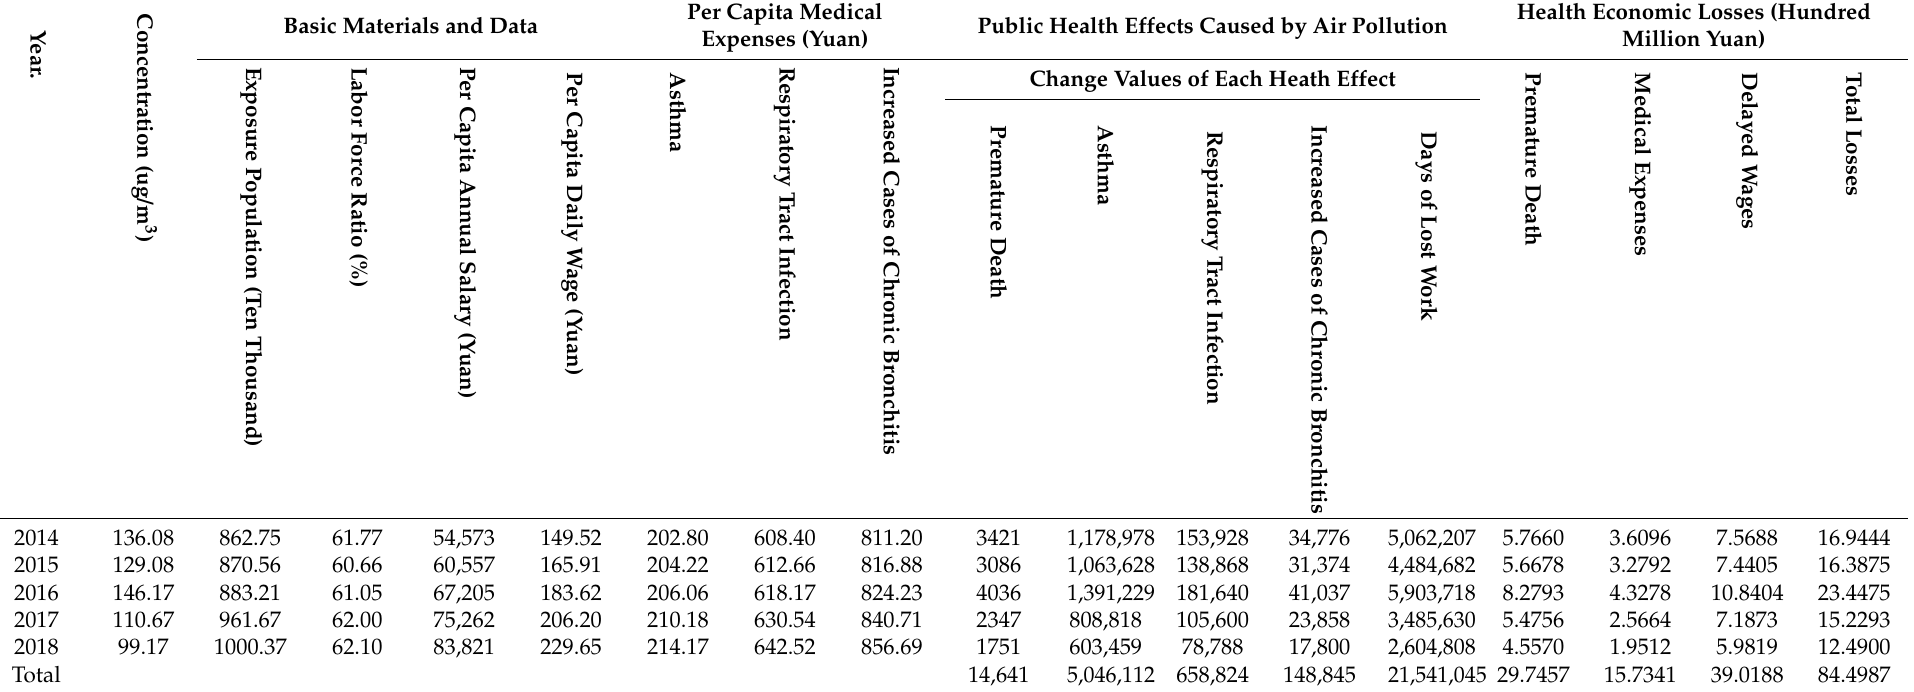
Table 7. Results of the public health effects caused by PM 10 and the corresponding economic losses from 2014 to 2018.